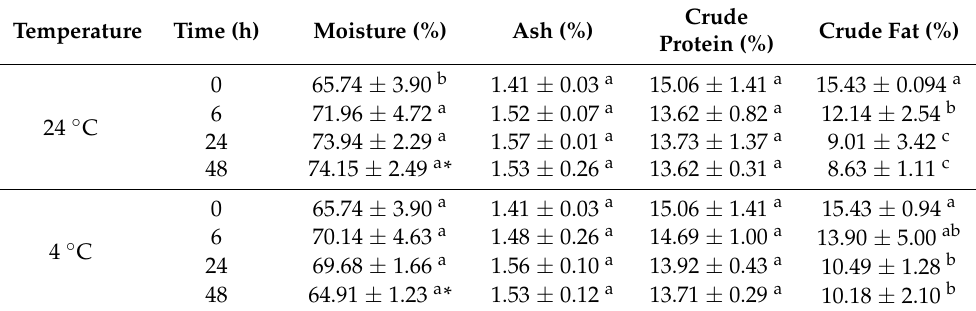
Table 3. Proximate composition of American shad under different storage conditions. Temperature Time (h) Moisture